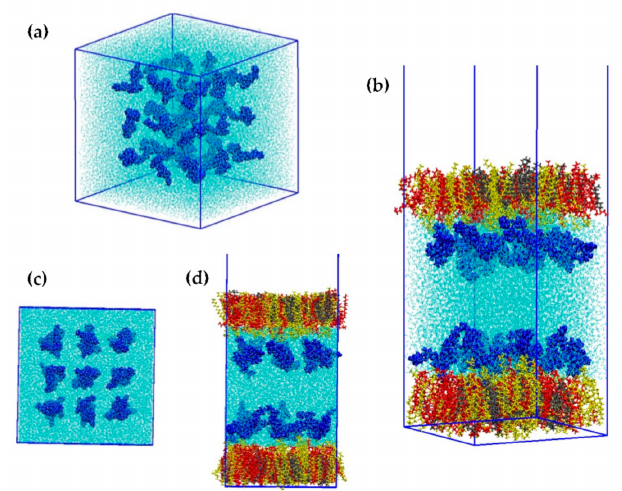
Figure 9. Perspective ( a , b ) and side ( c , d ) views of initial configurations of GOTCAB/H 2 O ( a , c ) and SM/POPC/CHOL/GOTCAB ( b , d ) molecular systems. Color code: GOTCAB: blue, SM: red, CHOL: gray, POPC: yellow, water: